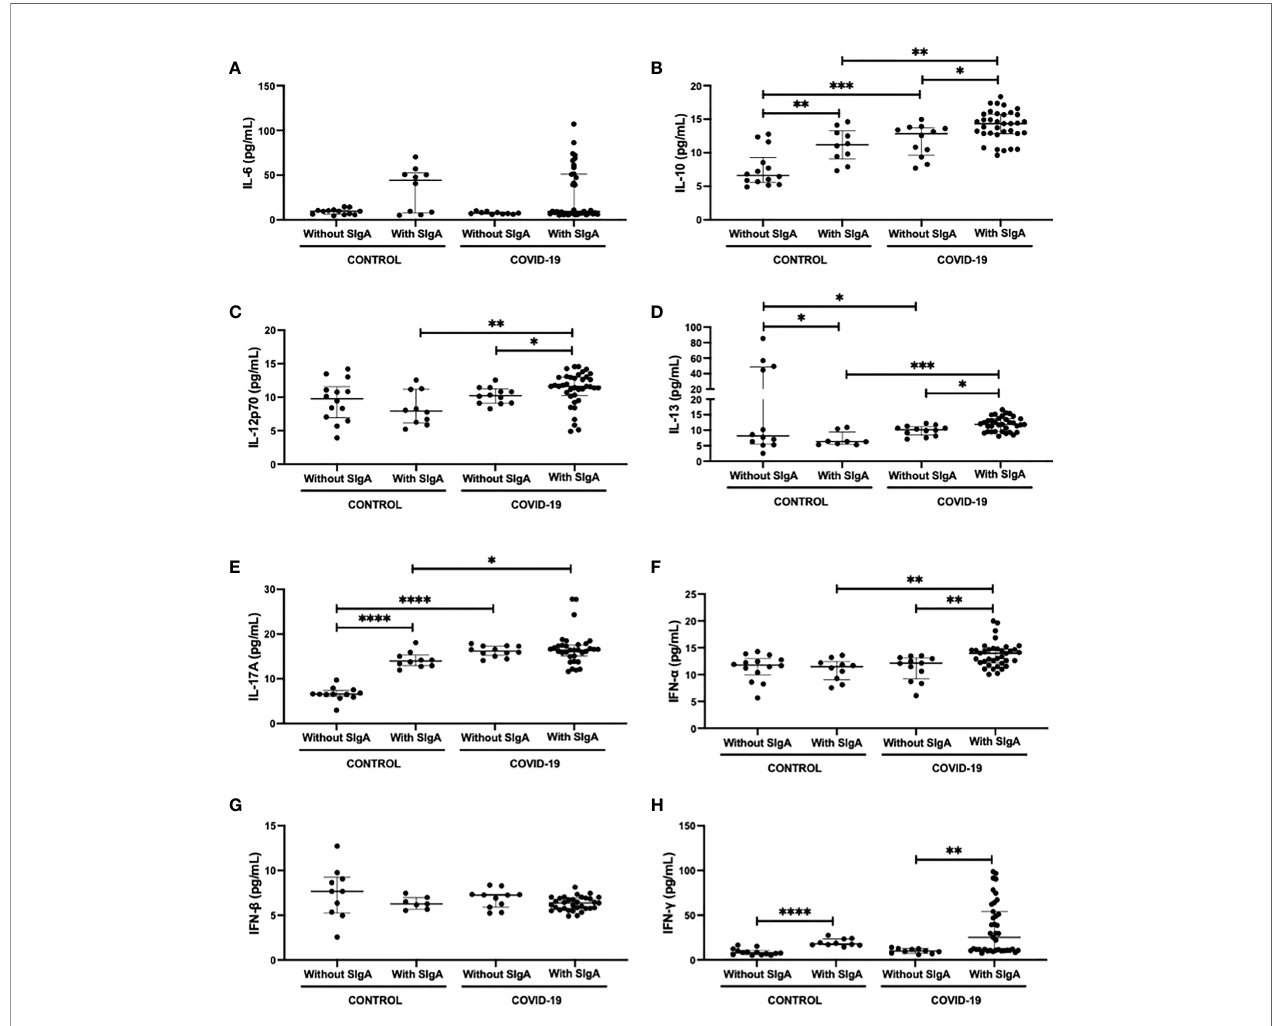
FIGURE 2 | Comparison of the salivary cytokines levels of IL-6 (A) , IL-10 (B) , IL-12p70 (C) , IL-13 (D) , IL-17 (E) , IFN- a (F) , IFN- b (G) , and IFN- g (H) between control without or with SIgA and COVID-19 without or with SIgA group. Values are presented in the median and interquartile range. Statistical analysis: Mann-Whitney test. The level of signi fi cance was established at 5% (* p < 0.05; ** p < 0.01; *** p < 0.001; **** p <